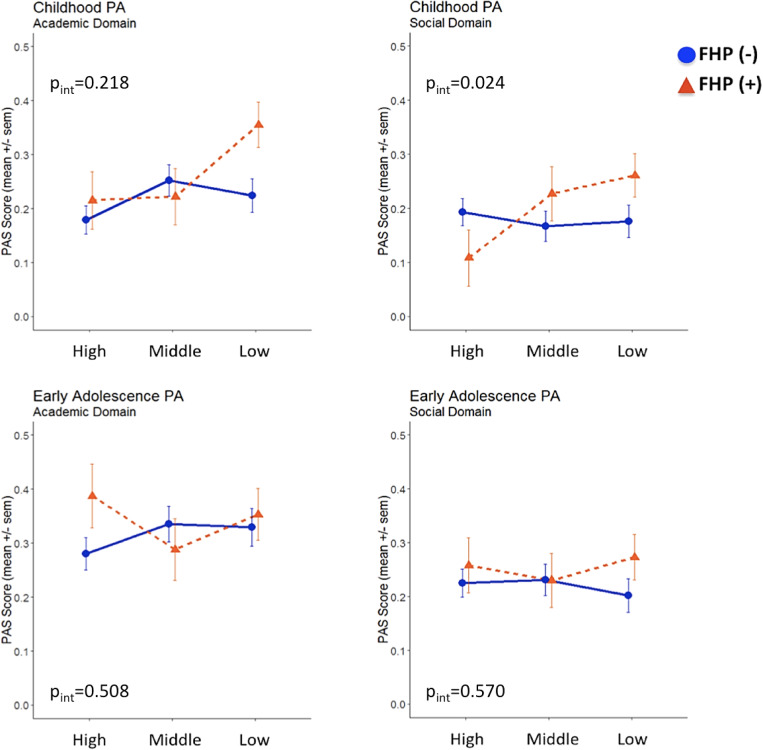
Academic and social premorbid adjustment domain scores in childhood and early adolescence following stratification for family history of psychosis and parental socioeconomic status.